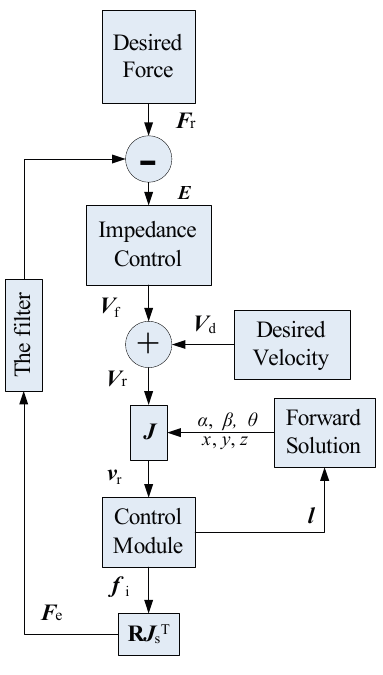
Figure 9. Components of the control